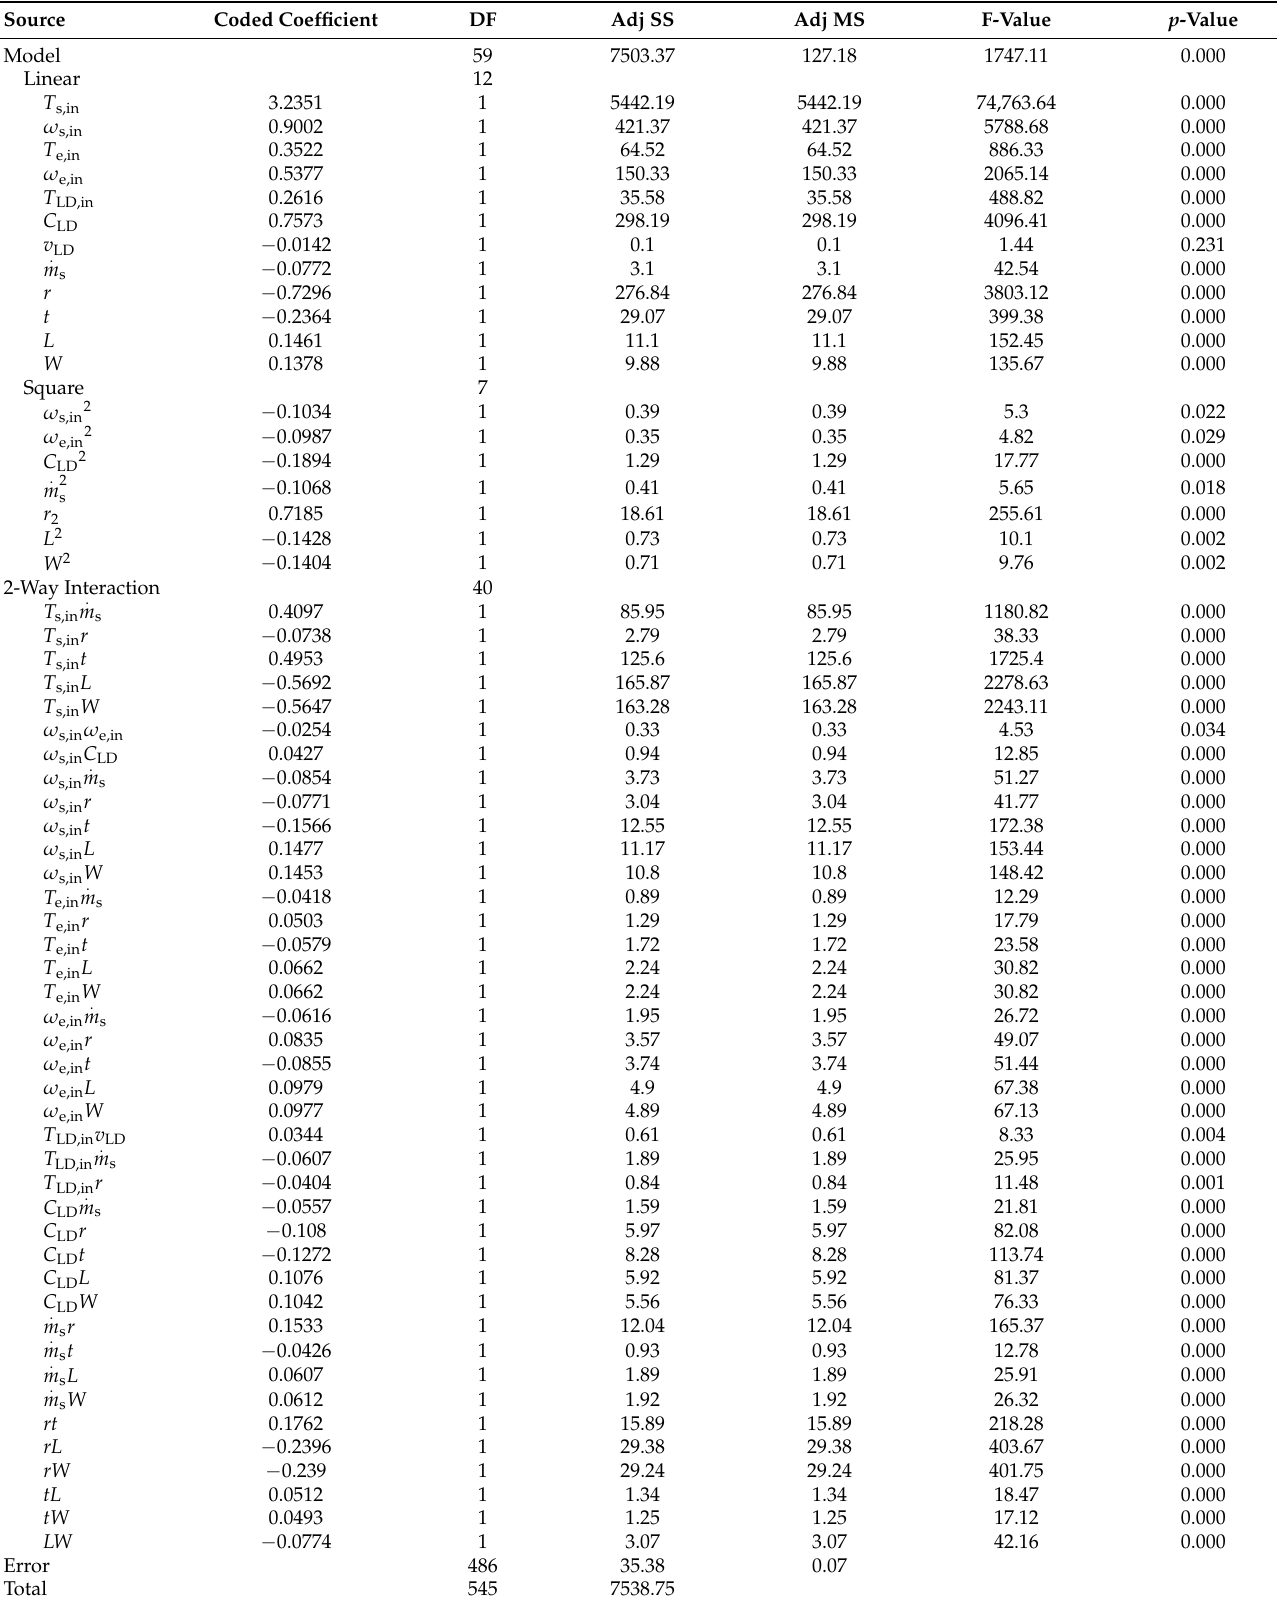
Table A3. ANOVA for the supply air outlet temperature regression